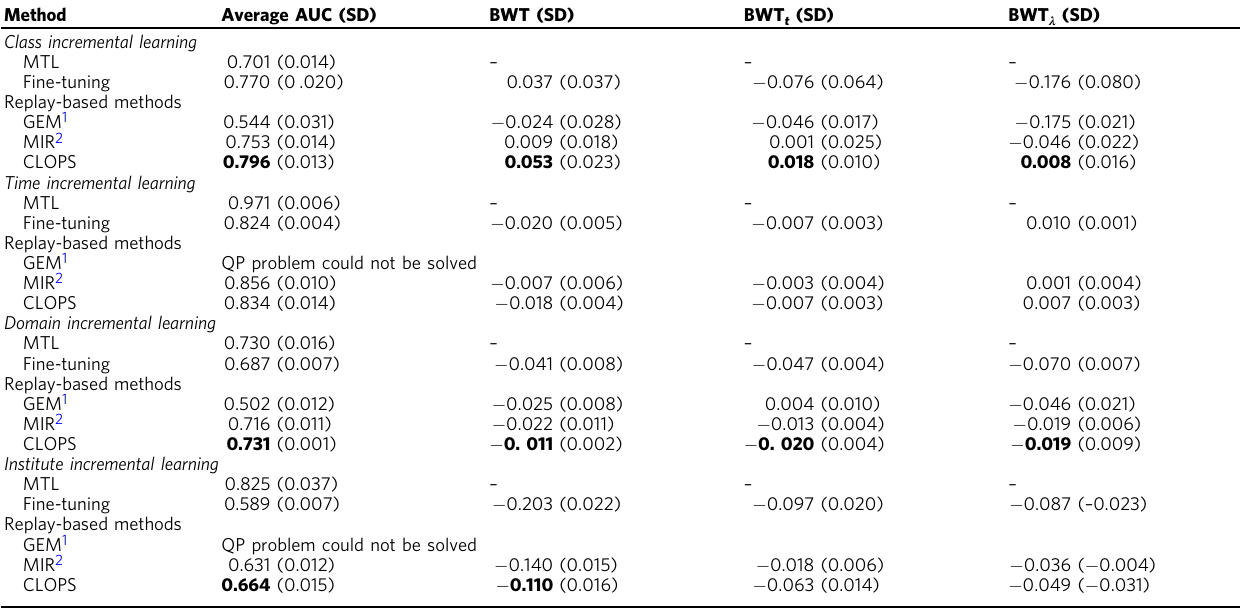
Table 1 Performance of various continual learning strategies in the continual learning